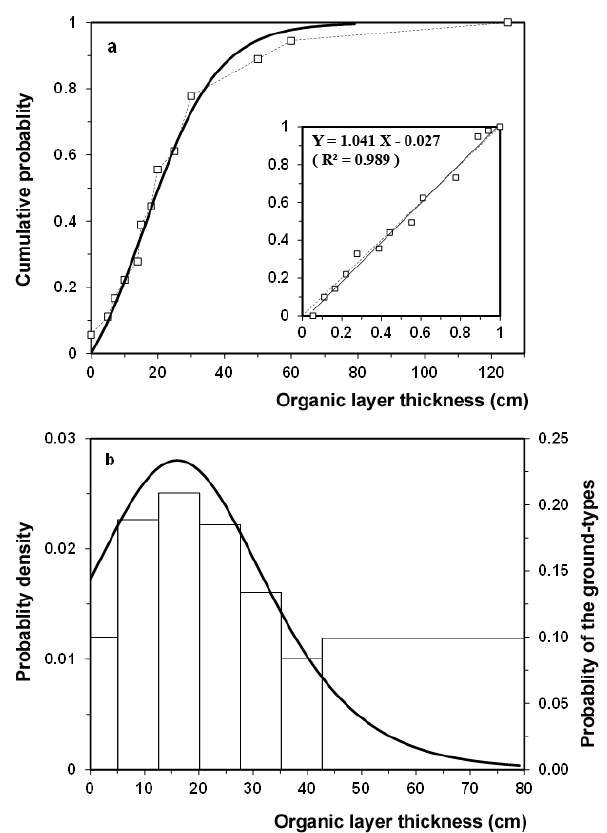
Figure 2. An example of determining the probability distribution of organic layer thickness for a land cover type (C2, coniferous forest – medium density). (a) Fitting the observed relative cumulative fre- quency (the dash curve) with a modified logistic function (the bold curve). The inset shows the scatter graph comparison and linear re- gression for the fitting. (b) The probability density (the bold curve), and the distribution of the ground types and their probabilities (the rectangle